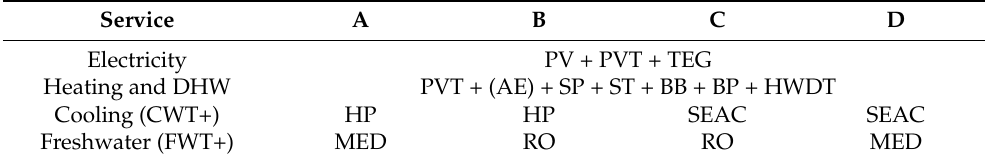
Figure 3. The general layout of the polygeneration schemes to serve the building demands. Table 4. Configurations analyzed in the polygeneration scheme.